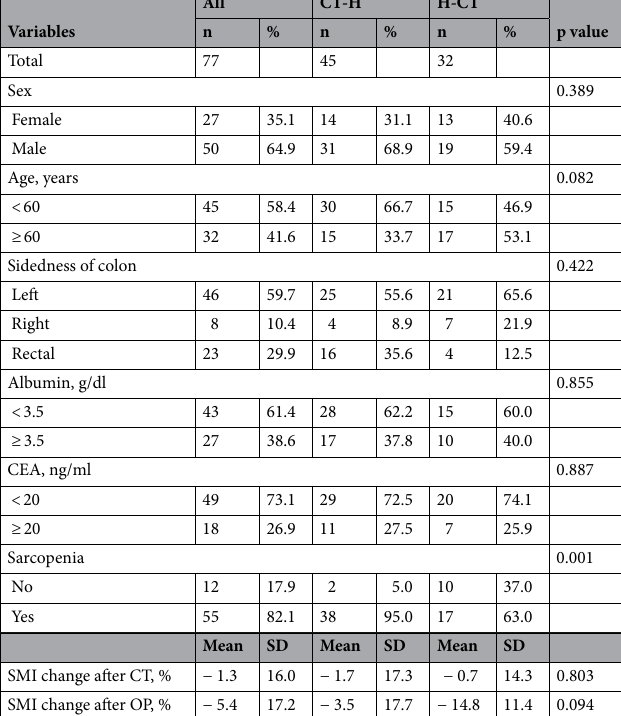
Table 1. Clinical characteristics of CT-H and H-CT